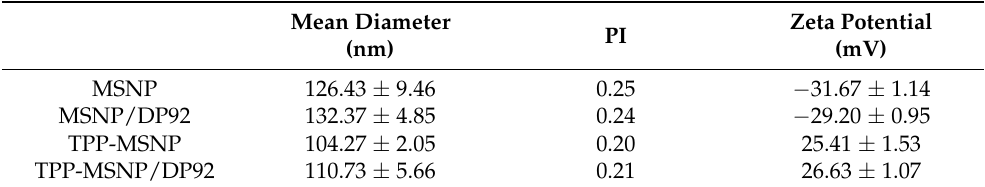
Table 1. Diameter, polydispersity index (PI), and zeta potential of MSNP or TPP-MSNP. Data are presented as mean ± SD ( n =